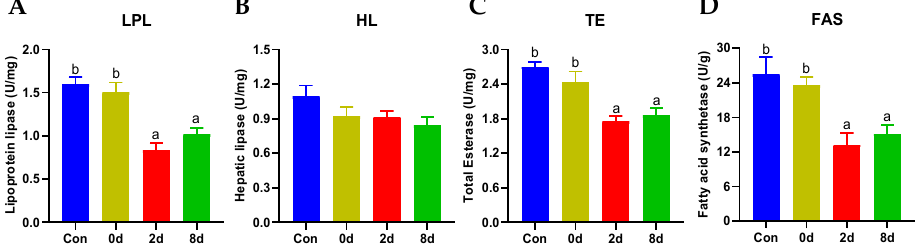
Figure 4. Effects of chronic hypothermia on lipid metabolism of freshwater drum. ( A ) Lipoprotein lipase, LPL; ( B ) Hepatic lipase, HL; ( C ) Total Esterase, TE; ( D ) Fatty acid synthetase, FAS. Data were calculated by one-way ANOVA analysis with SPSS 23.0. The significant differences are considered to exist when p < 0.05, and marked with different letters. Results were expressed as mean ± SEM, n = 6.